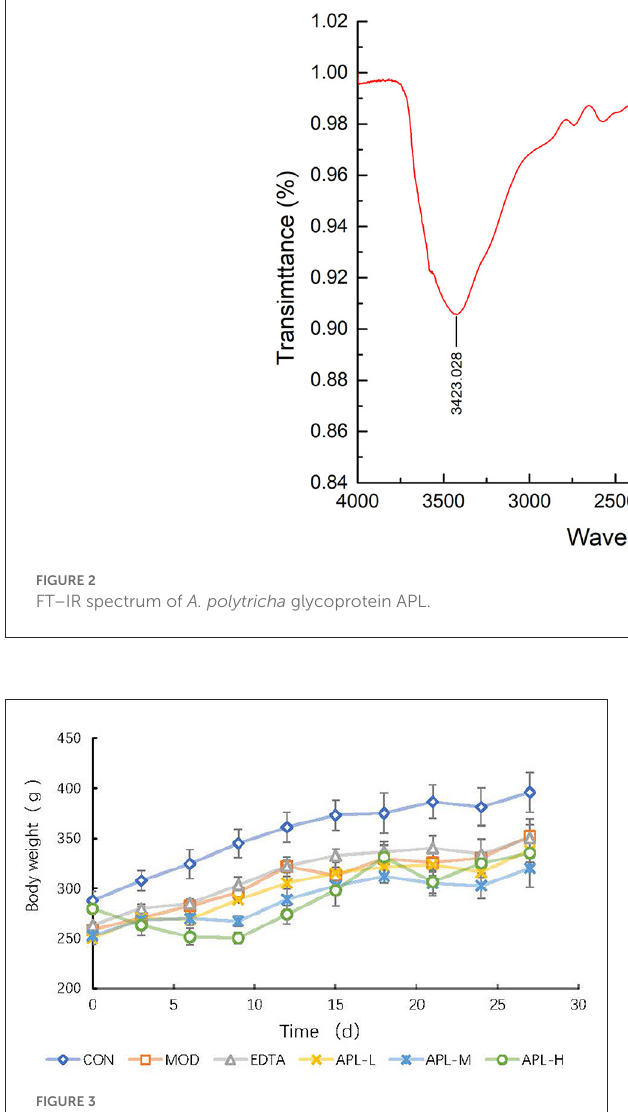
FIGURE3 Time course study of the effect of APL in preventing lead-induced fall in body weight. APL-L, APL-M, and APL-H represent 40, 80, and 160mg APL/kg body weight, respectively. Results are presented in mean ± standard deviation ( N =